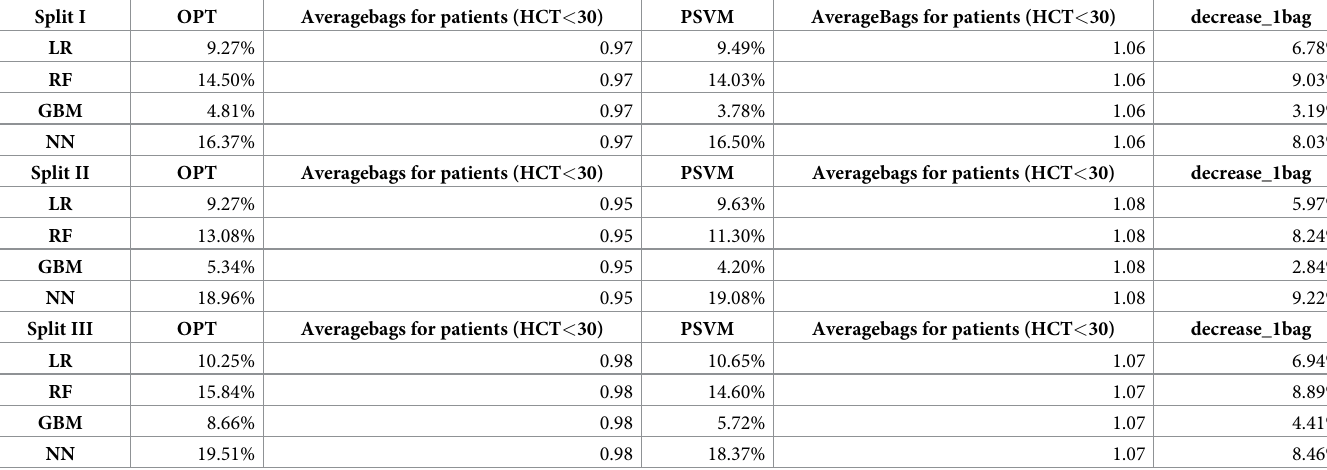
Table 4. Percentage reduction of readmissions due to increase in pre-operative